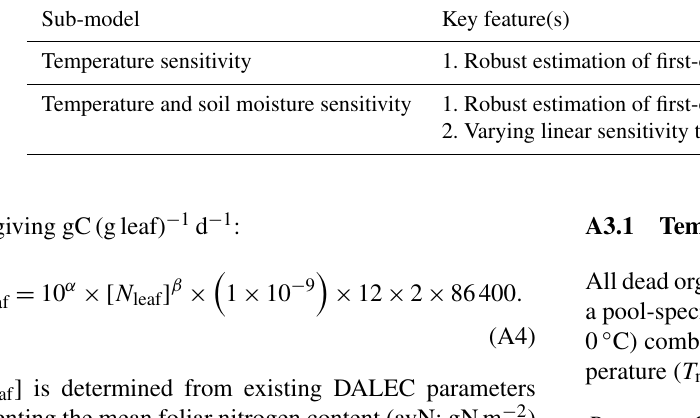
Table A3. Summary of key features for each decomposition sub-model. Sub-model Key feature(s) Temperature sensitivity 1. Robust estimation of first-order exponential temperature sensitivity Temperature and soil moisture sensitivity 1. Robust estimation of first-order exponential temperature